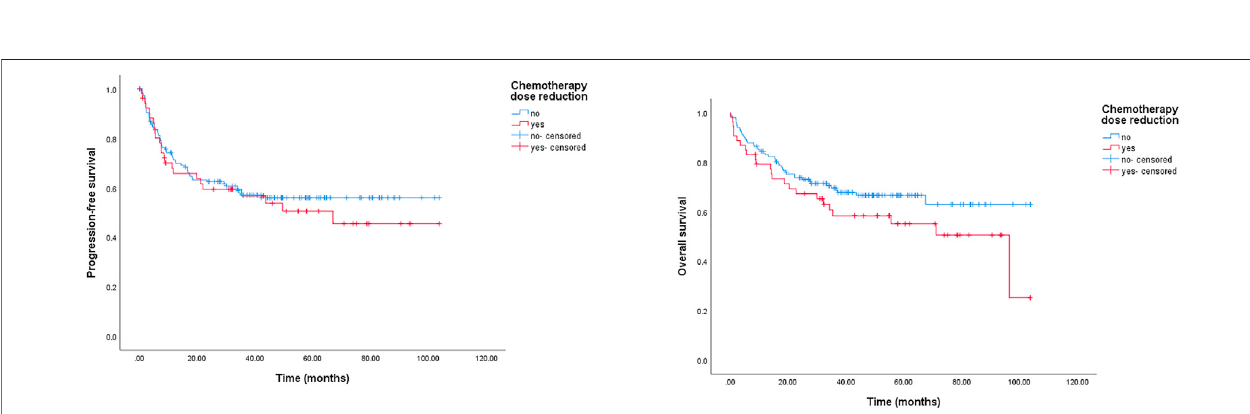
FIGURE 2 | Kaplan-Meier survival curve of PFS and OS for DLBCL patients strati fi ed by rituximab usage. The 2-year PFS rates were 61.7% (rituximab group) and 49.1% (no rituximab group), respectively, p = 0.082; the 2-year OS rates were 72.9% (rituximab group) and 56.8% (no rituximab group), respectively, p = 0.008.